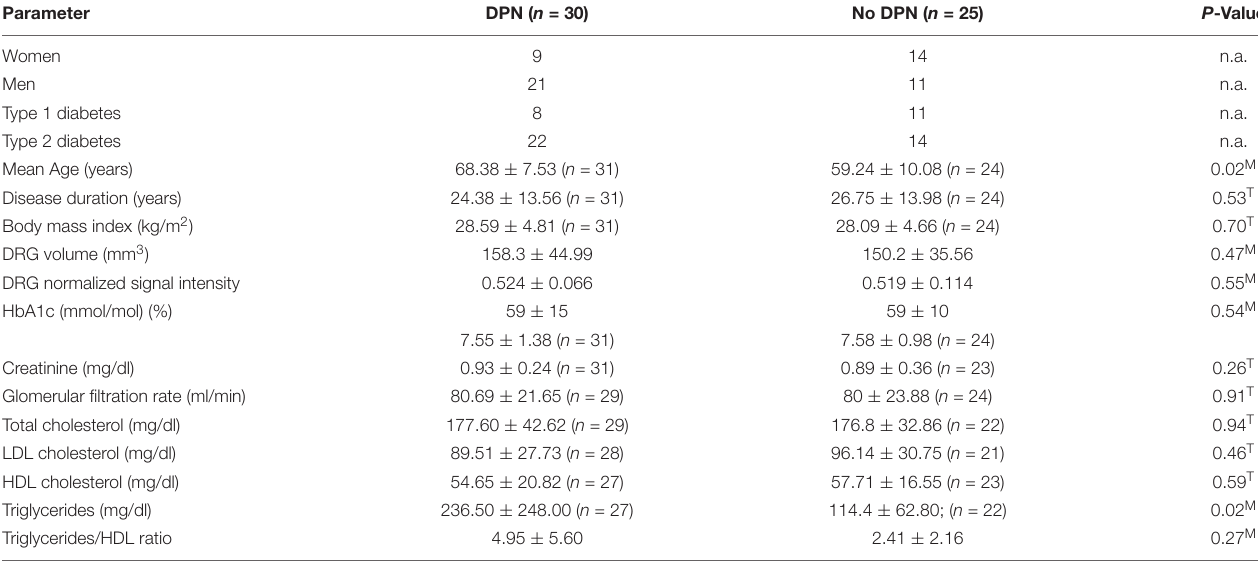
TABLE 1 | Demographic, MRN, and serologic data in patients with and without diabetic neuropathy. Parameter DPN ( n = 30) No DPN ( n =